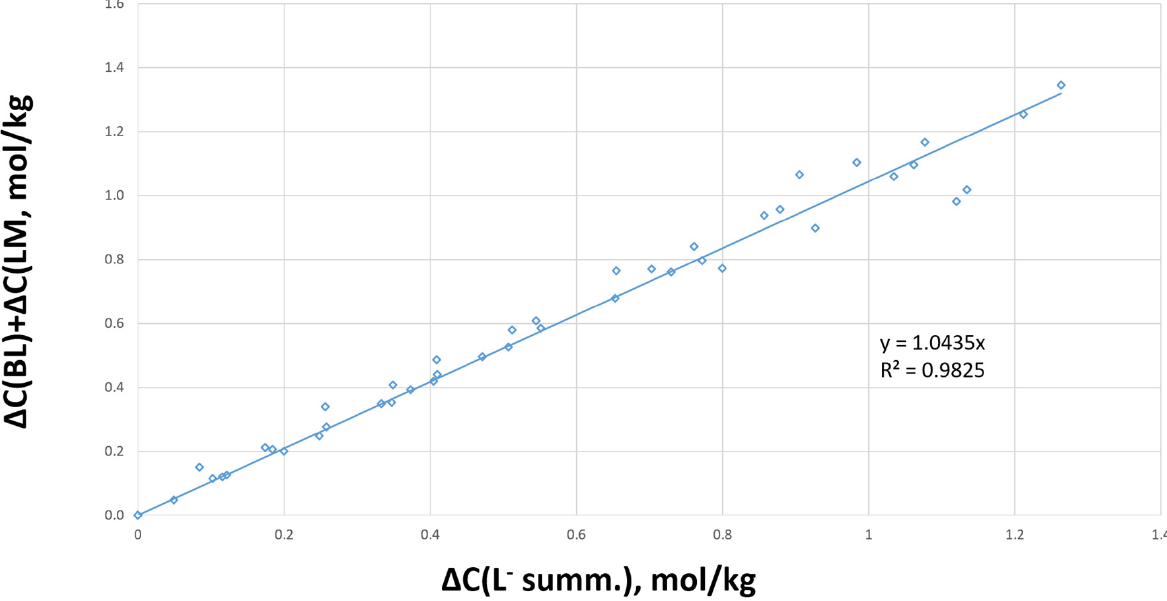
Figure 2. Dependence of increment in butyl lactate (BL) and lactamide (LM) concentrations ( ∆ C(BL) + ∆ C(LM)) on the decline in ammonium lactate (AL) and lactic acid (LH) concentrations ∆ C(L − summ.) = ∆ C(LH + AL). ∆ C(i) = |C(i)0 − C(i)|.